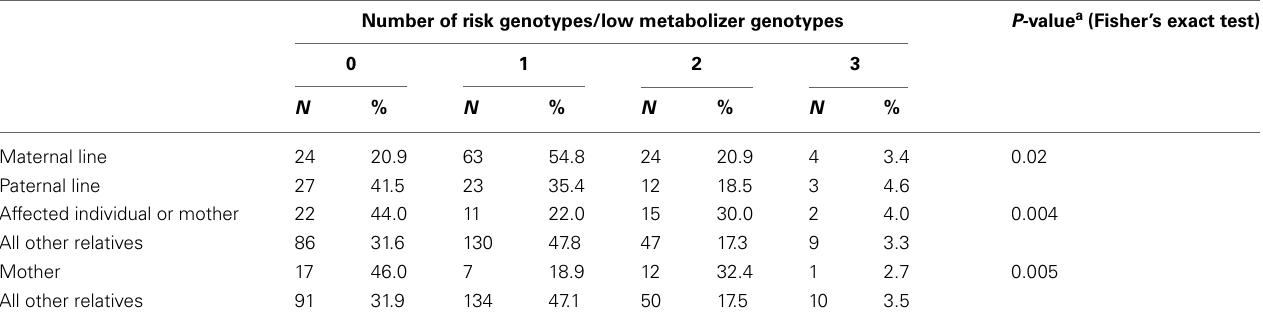
Table 5 | Number of risk genotypes by relationship to affected individuals with NTDs and lineage, northeast region of the Republic of Ireland and Northern Ireland,